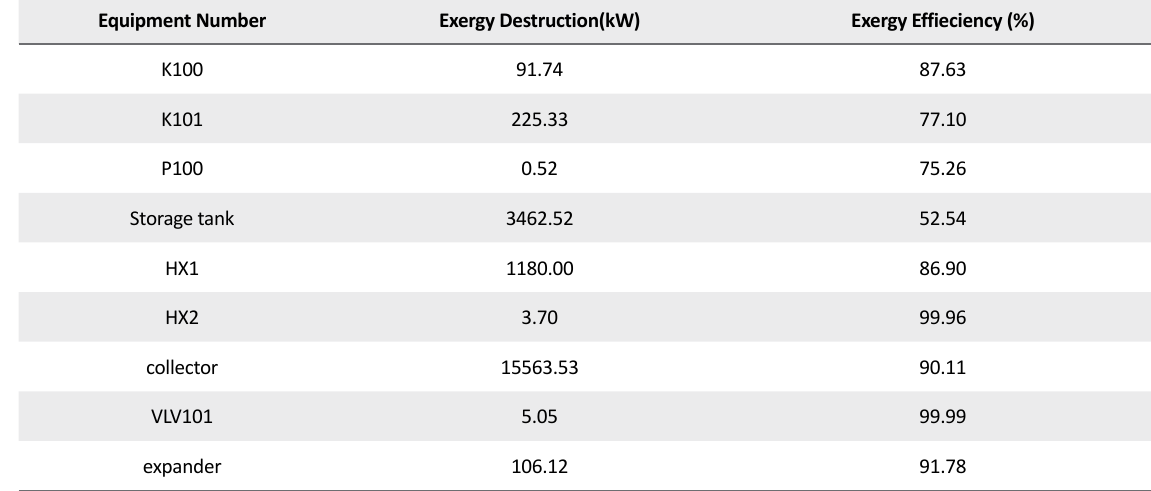
Table 3. Results of the equipment analysis exergy Equipment